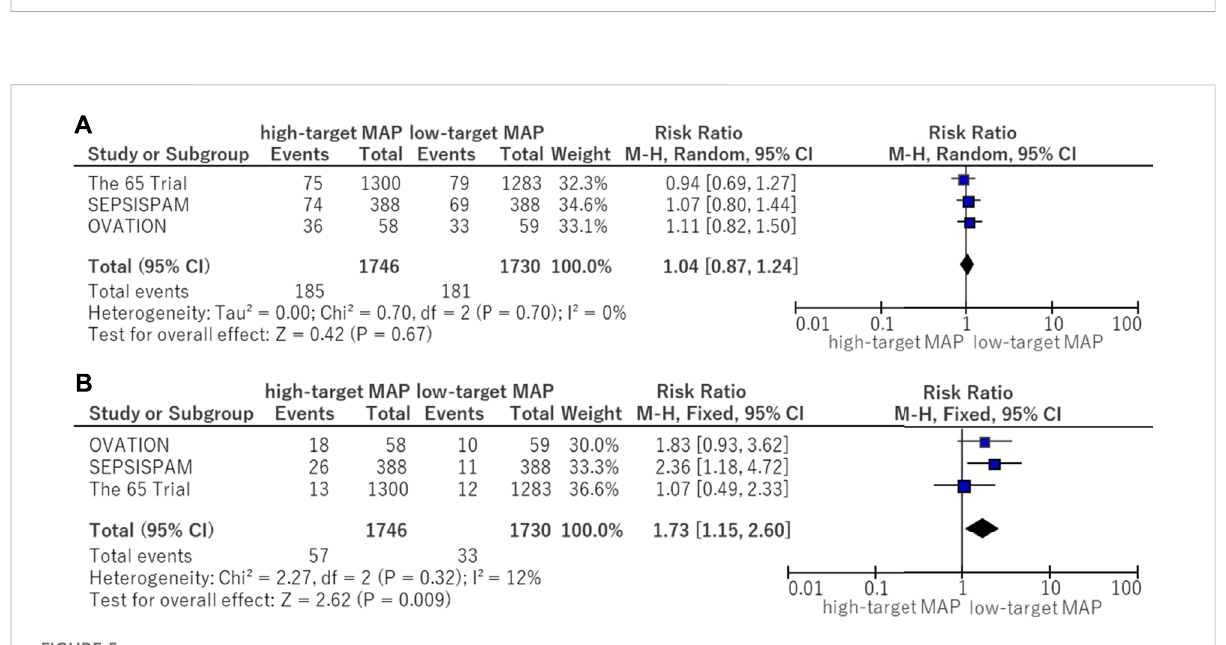
FIGURE 5 ForestplotofthecomparisonofahigherMAPversuslowerMAP:adverseevents. (A) Seriousadverseevents. (B) Supraventriculararrhythmia.CI, con fi dence interval; M-H, Mantel – Haenszel; MAP, mean arterial